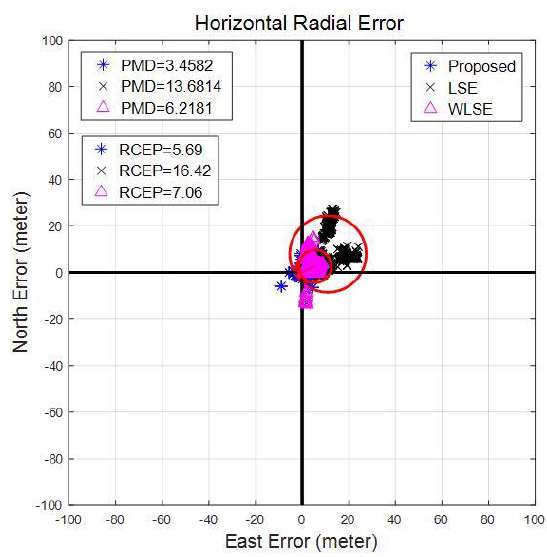
Figure 5. Horizontal radial error for emulated scenario 1.